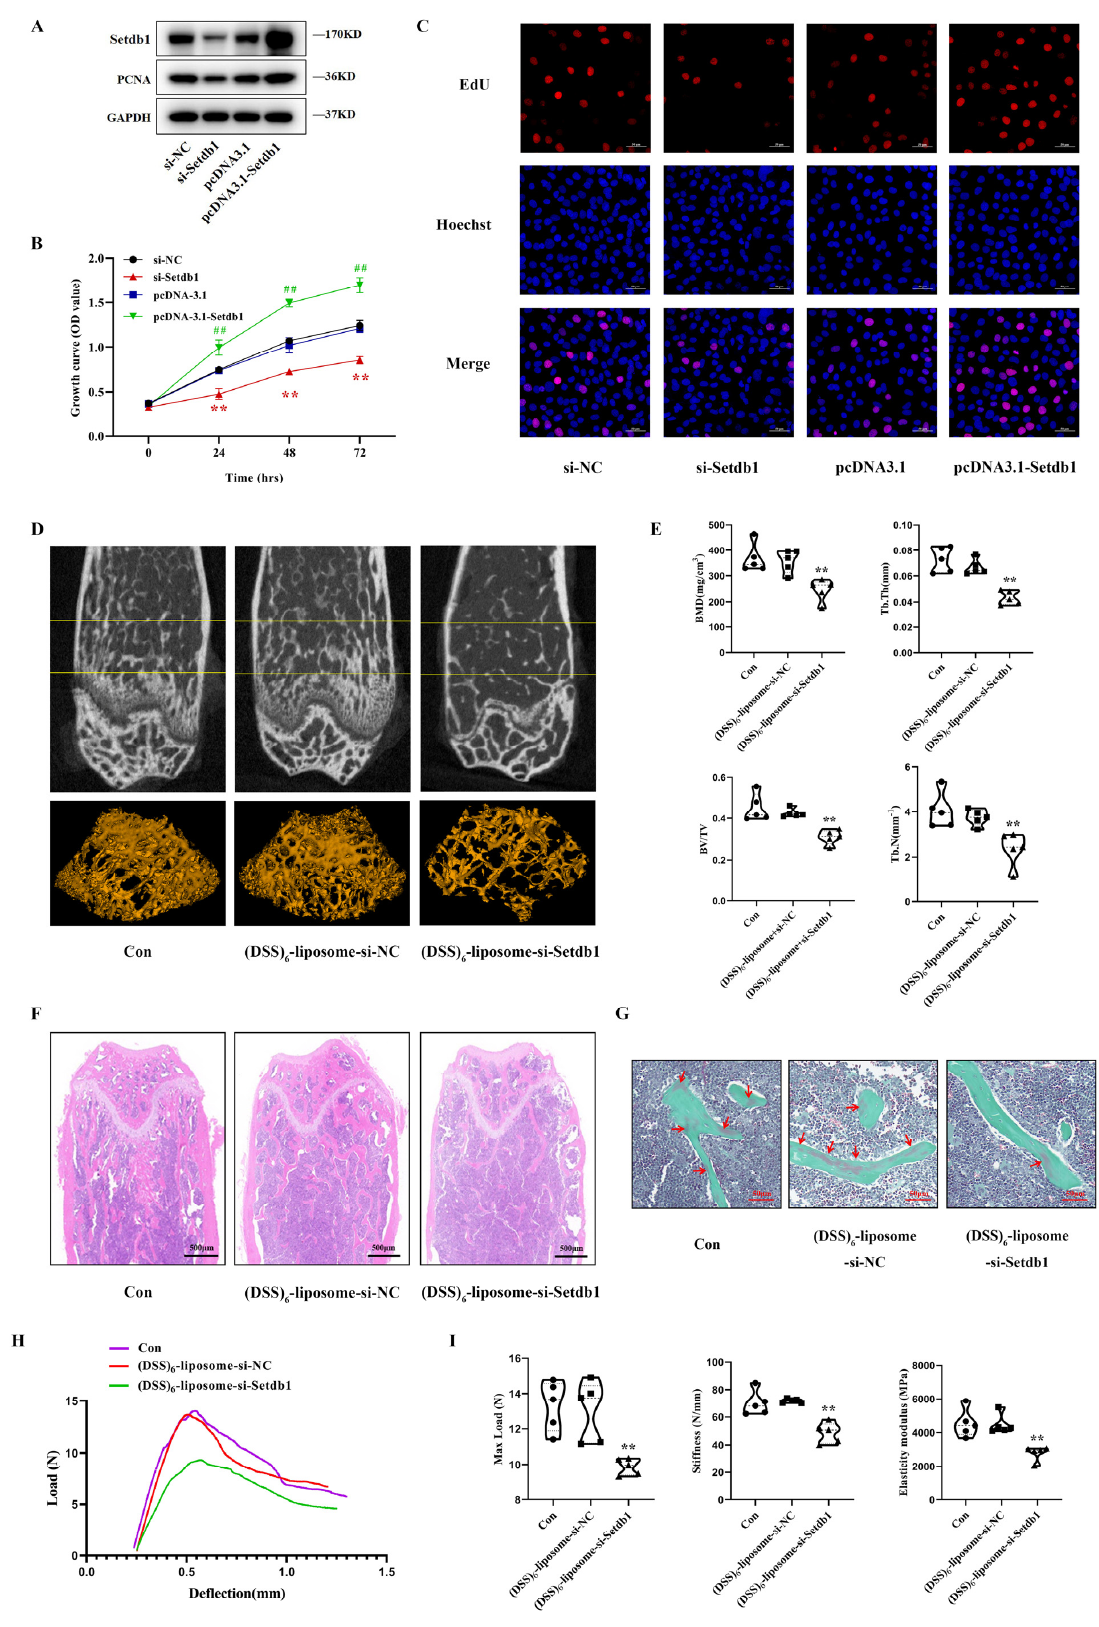
Figure 2. Setdb1 regulates osteoblast proliferation and bone formation. ( A ) The protein level of Setdb1 and PCNA in MC3T3-E1 cells by Western blotting after transfection of si-Setdb1,